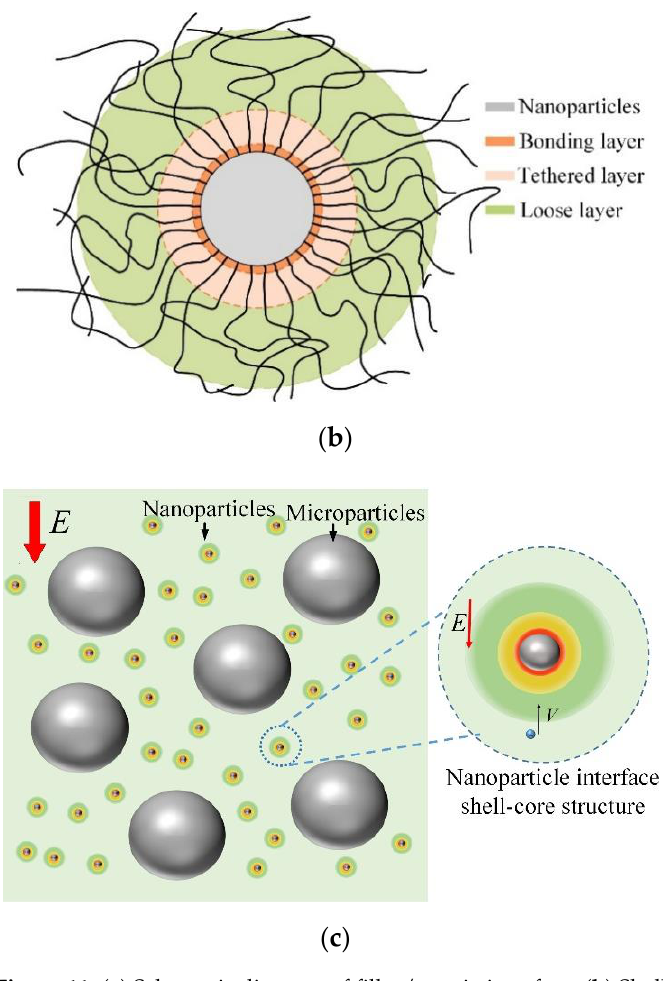
Figure 11. ( a ) Schematic diagram of filler/matrix interface; ( b ) Shell-core structure of nanoparticles and matrix; ( c ) Schematic diagram of micro/nanoparticle composites.